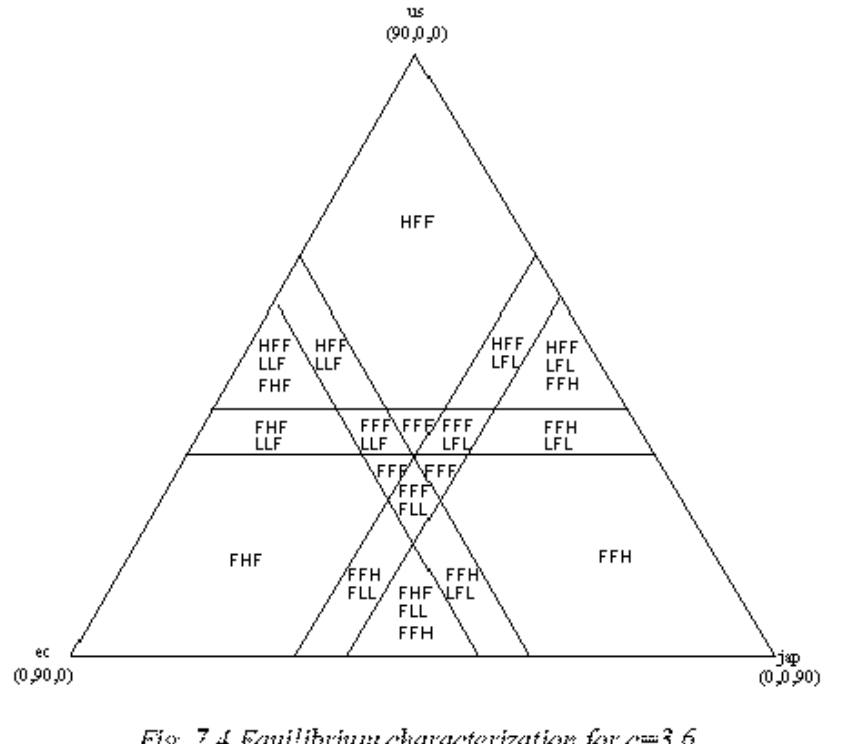
Fig. '.4 should be cn1npared "with Fig.>.! and the ,le,cription thereafter. The tffJ ,'LLF trupezirnn gct, longer, the HFF'LLF'FHFtriangle gets larger, the 'do"wnwan:lly' directed triangle armmd the center gets ,1naller and now exteml, from u,=36 and do"wn to the center (